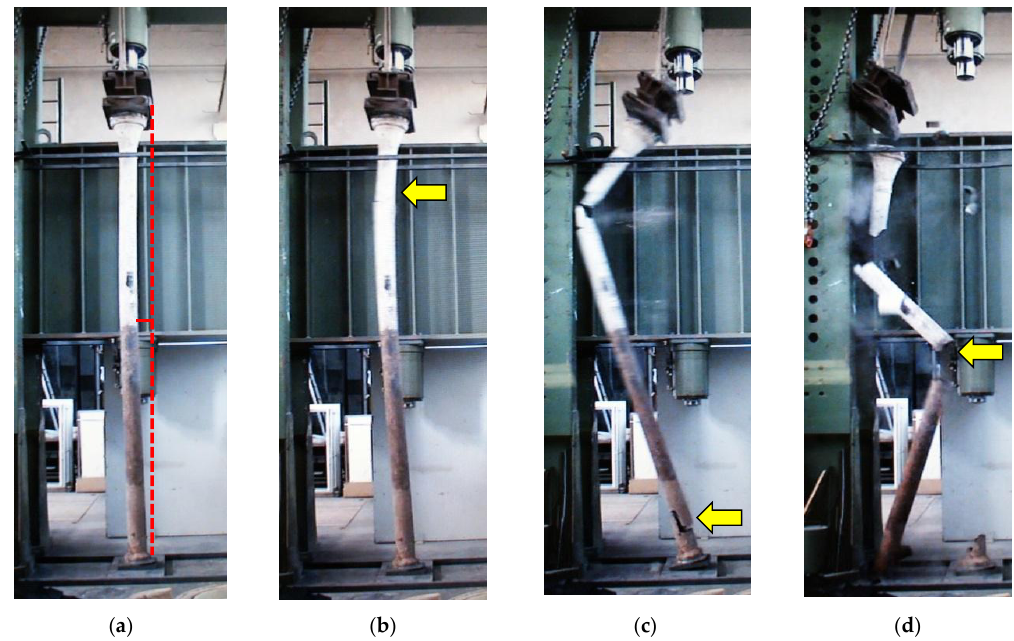
Figure 5. Course of the final stage of the test [19]: ( a ) buckling of the column, ( b ) occurrence of the first crack, ( c ) occurrence of the second crack at the column base, ( d ) facture at the mid-height (with the red line primary axis of the column has been marked, while the yellow arrows indicate the locations of the